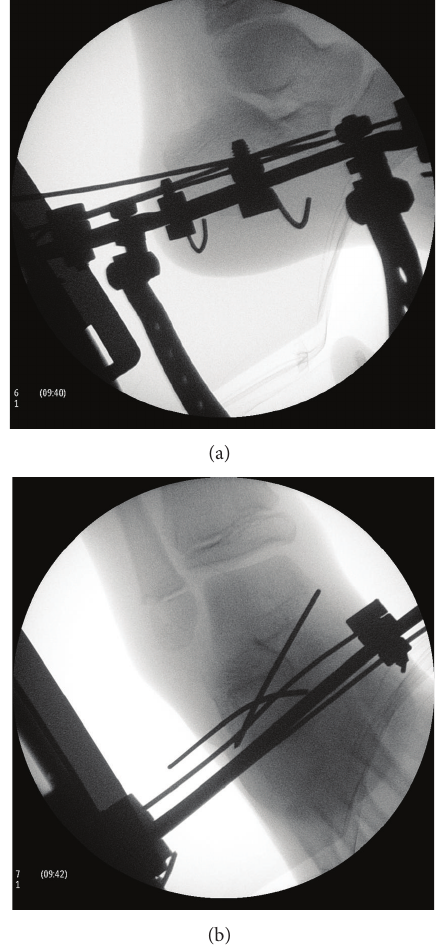
Figure 5: (a) Lateral radiograph confirming anatomical reduction. (b) Anteroposterior radiograph confirming anatomical reduction and demonstrating position of K-wires.